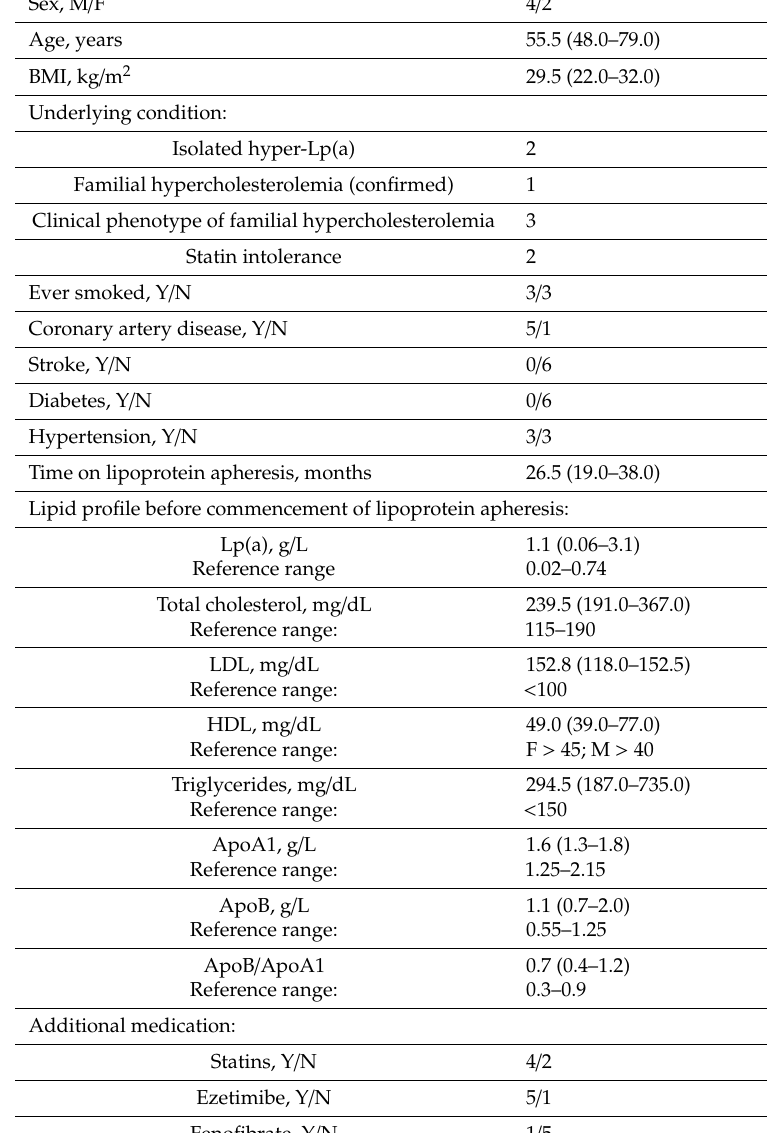
Table 1. Baseline characteristics of the participants. The data are given as medians and range, n =